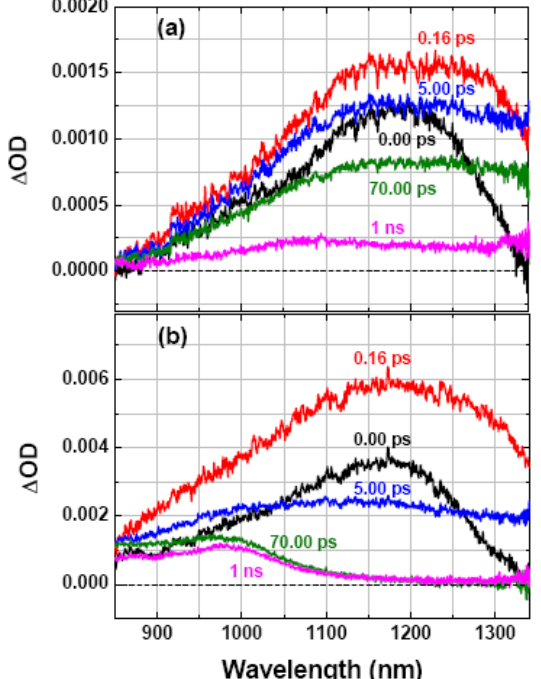
Figure 1. Transient spectra at selected delay times recorded following photoexcitation at 620 nm for ( a ) SVA neat P3HT film and ( b ) SVA P3HT/PC Excitation photon fluence were 4.3 × 10 17 and 7.8 × 10 17 photons·cm − 3 ·pulse − 1 for ( a ) and ( b )